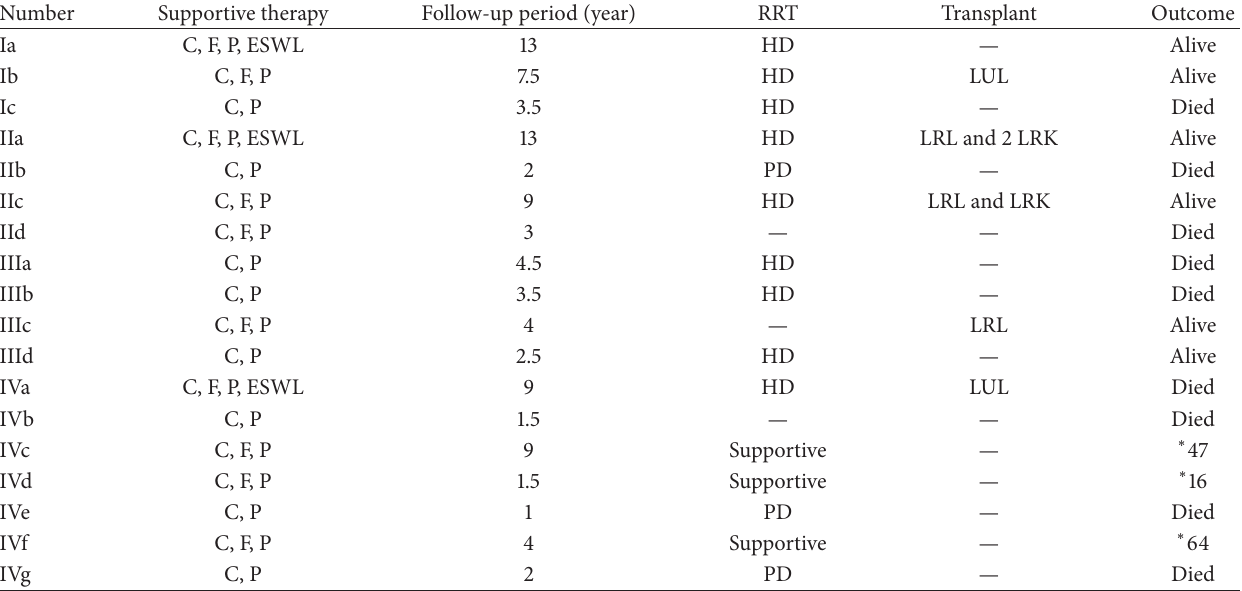
Table 2: Management and